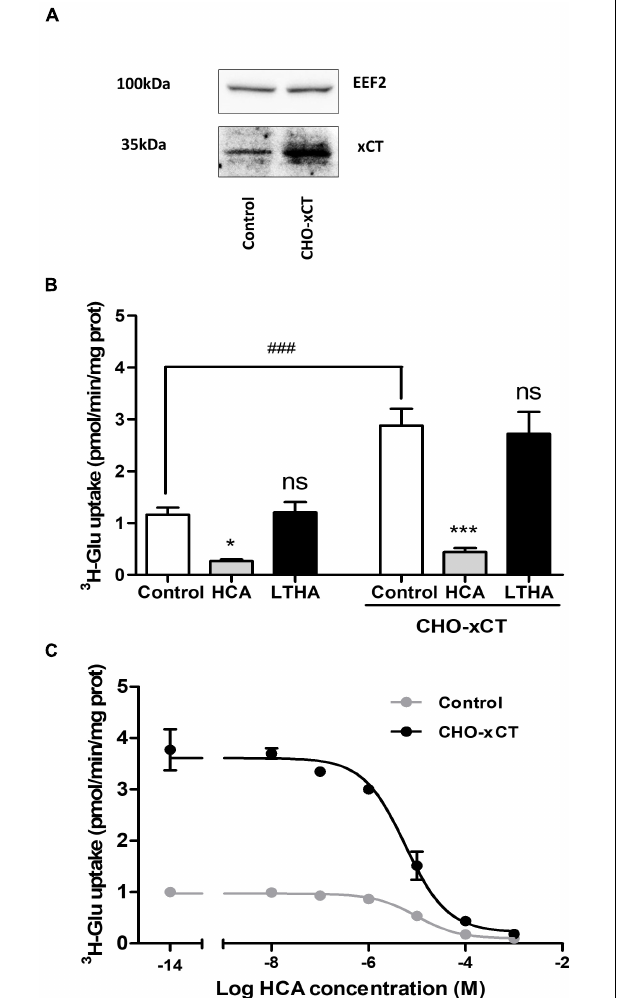
FIGURE 3 | Influence of xCT overexpression on [ 3 H]- L -glutamate uptake capacity of CHO cells. The increased expression of xCT was validated by Western blotting comparing protein samples from control and CHO-xCT cells using a specific rodent xCT antibody. Detection of the EEF2 was used as a control for sample loading and protein blotting. The blot shown is representative of three independent experiments (A) . [ 3 H]- L -glutamate uptake capacity was measured on control and CHO-xCT cells. Pharmacological inhibitors (10 − 4 M) were added to the preparation to further confirm the nature of the transporter involved (B) . The potency of HCA at inhibiting system x c − -dependent [ 3 H]- L -glutamate uptake capacity was examined by performing the assay in the presence of increasing concentrations of HCA (C) . Data represent the mean of the uptake capacity with SEM from three independent experiments performed in quadruplicate. Statistical analyses were performed using a one-way ANOVA followed by a Dunnett’s test for multiple comparisons [ns p > 0.05, * p < 0.05, *** p < 0.001 refer to the comparison within the same cellular population (vs. control). ### p < 0.001 refers to the comparison between CHO and CHO-xCT cells].